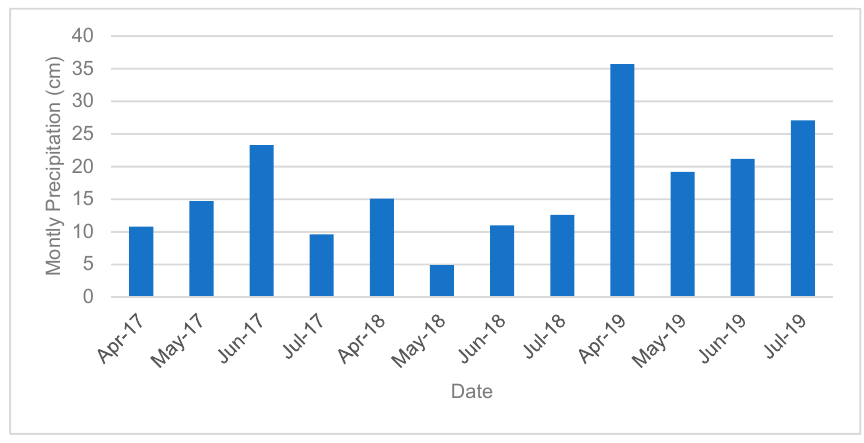
Figure 2. Monthly precipitation chart for the growing seasons: 2017, 2018, and 2019.